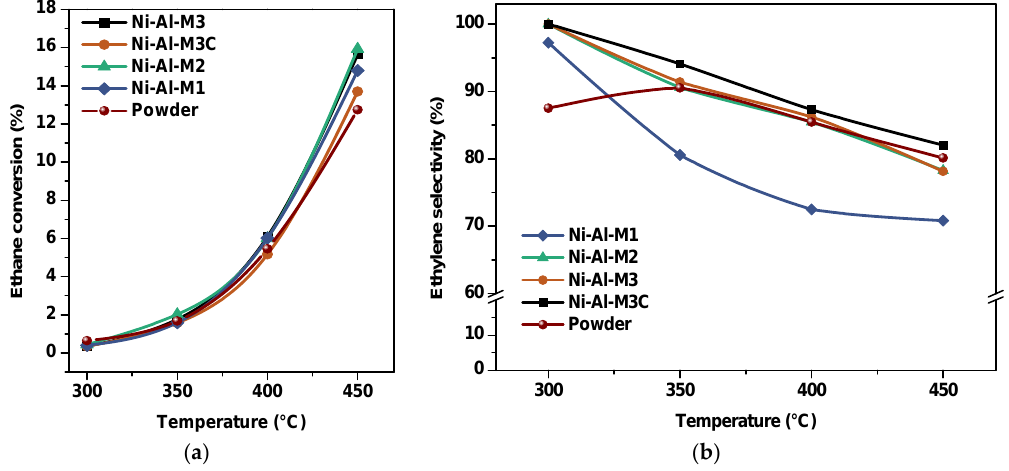
Figure 8. Catalytic activity at W/F = 0.48 g ∙ s/cm 3 . ( a ) Ethane conversion and ( b ) ethylene selectivity.